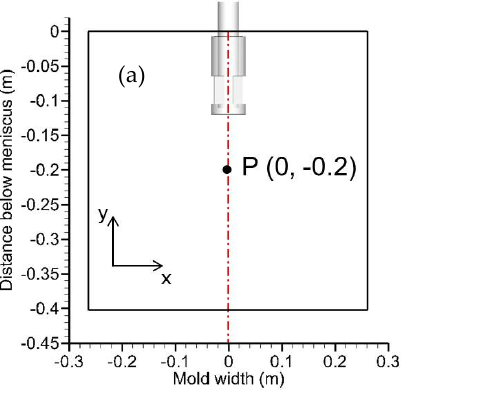
Figure 17. The relationship between the flow rate at a specific point P in the wide slab continuous casting mold and the blowing rate. ( a ) The position of the specific point P and ( b ) the effect of blowing rate on the flow rate at point P.